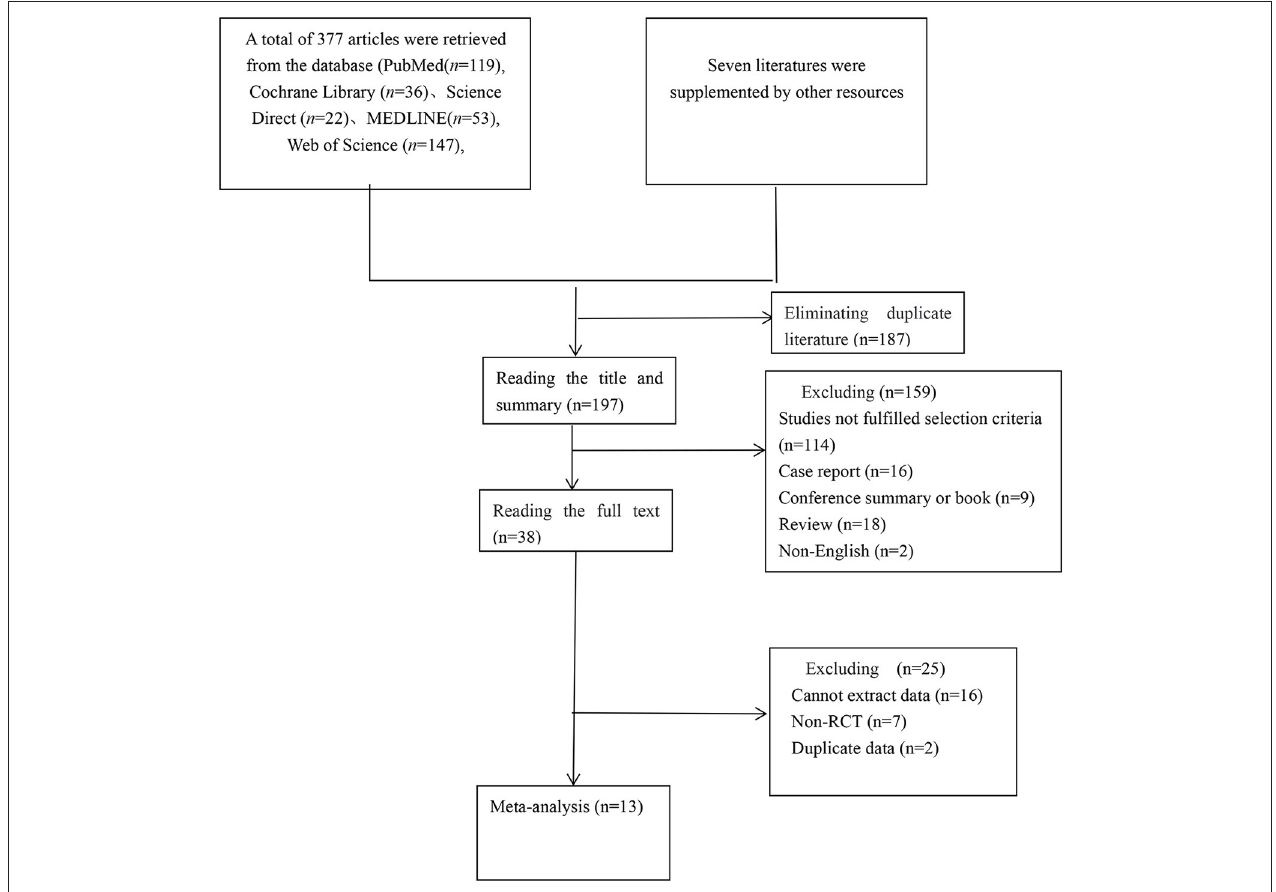
FIGURE 1 | Flow chart of study